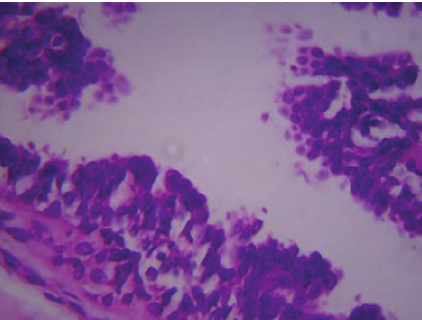
Figure 5: Duct papilloma (H&E staining, magnification